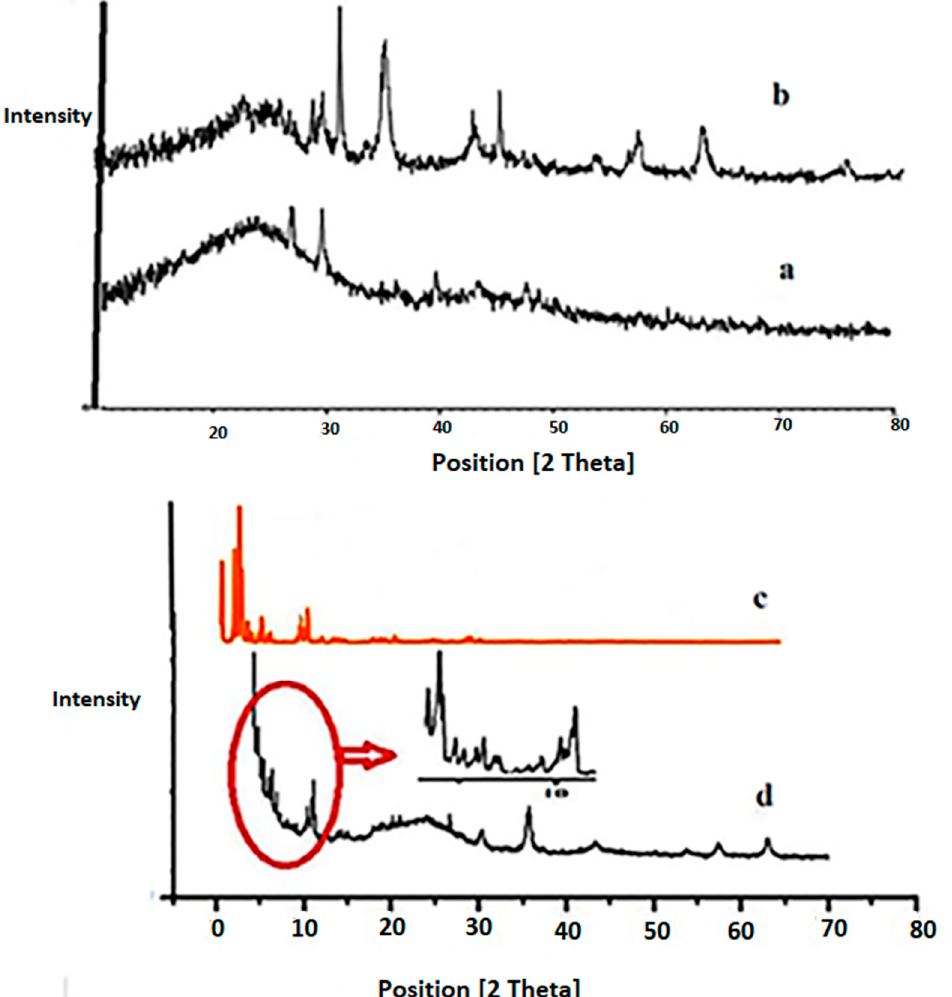
Figure 1. XRD pattern of ( a ) activated charcoal (AC), ( b ) Fe 3 O 4 @AC, ( c ) MIL-100(Fe)-simulated [42], and ( d ) MIL-100(Fe) @Fe 3 O 4 @AC.